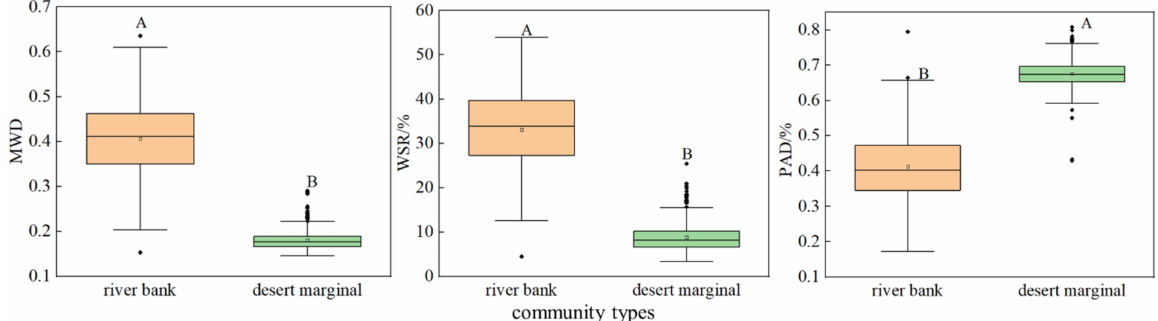
Figure 3. The difference in the soil aggregate stability of different community types. Note: MWD, mean weight diameter; WSR, the percentage of soil aggregates with a particle size larger than 0.25 mm; PAD, the percentage of aggregate destruction. The different letters (A and B) indicate statistically significant differences between the two communities ( p < 0.05).